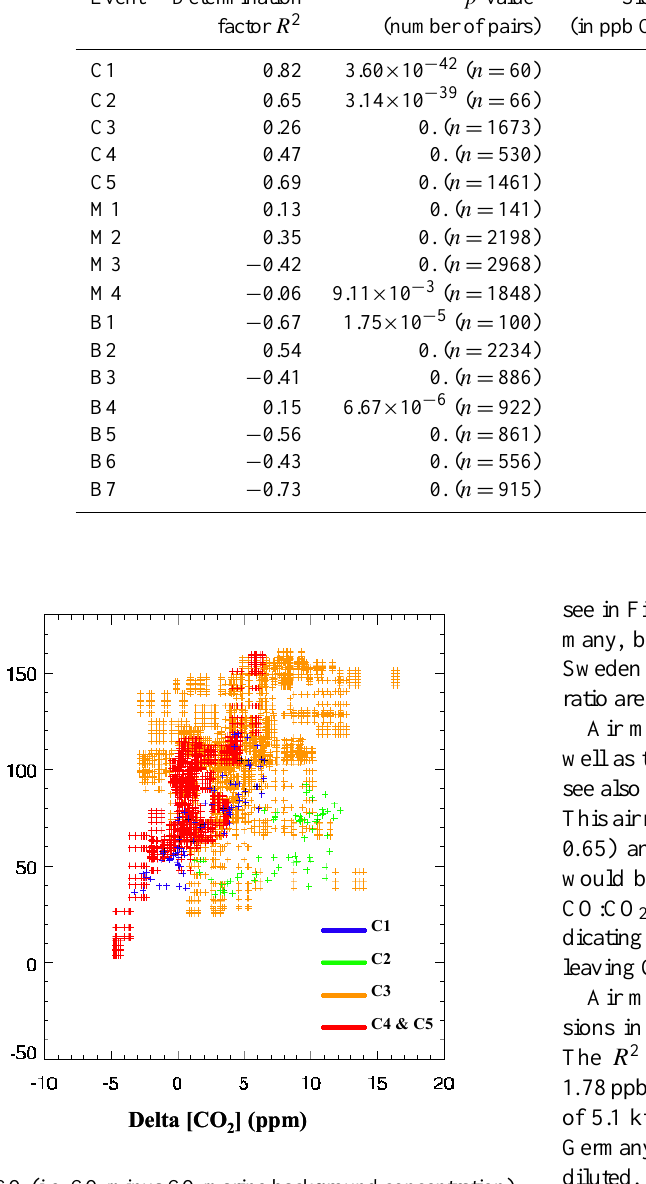
(Fig. 6c). The mean observed slope is 3.2 ppb CO ppm − 1 CO 2 , close to the emission inventory ratio value for Czech Republic (4.4 kt CO/Mt CO 2 ) , but less close to the one for Austria (10.4 kt CO/Mt CO 2 ) . Thus, fossil fuel CO 2 from Czech Republic must have had a dominant influence on these air masses. However, the large scattering around the linear regression line ( R 2 = 0 . 47) indicates interplay of combustion sources with different